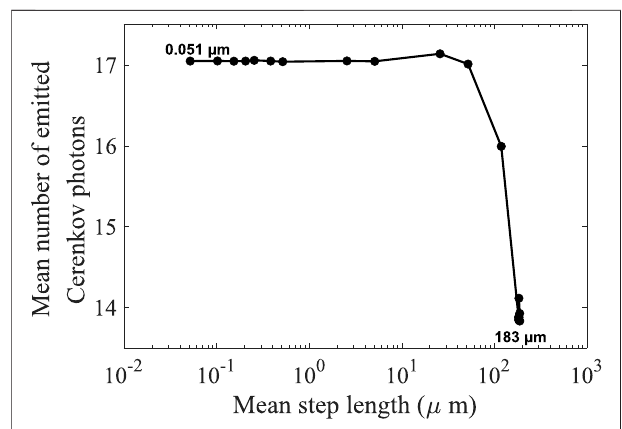
FIGURE 5 | Mean number of emitted Cerenkov photons per 511 keV photoelectric interaction in BGO as a function of the electron mean step length. The electron mean step length is varying in the simulations since different limitations on the electron velocity change per step are